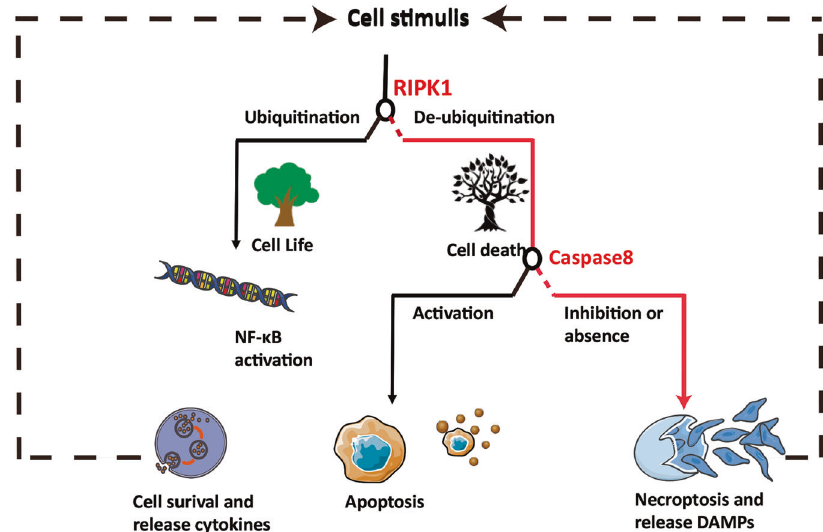
the RHIM domain with the RHIM domain of RIPK3 to activate